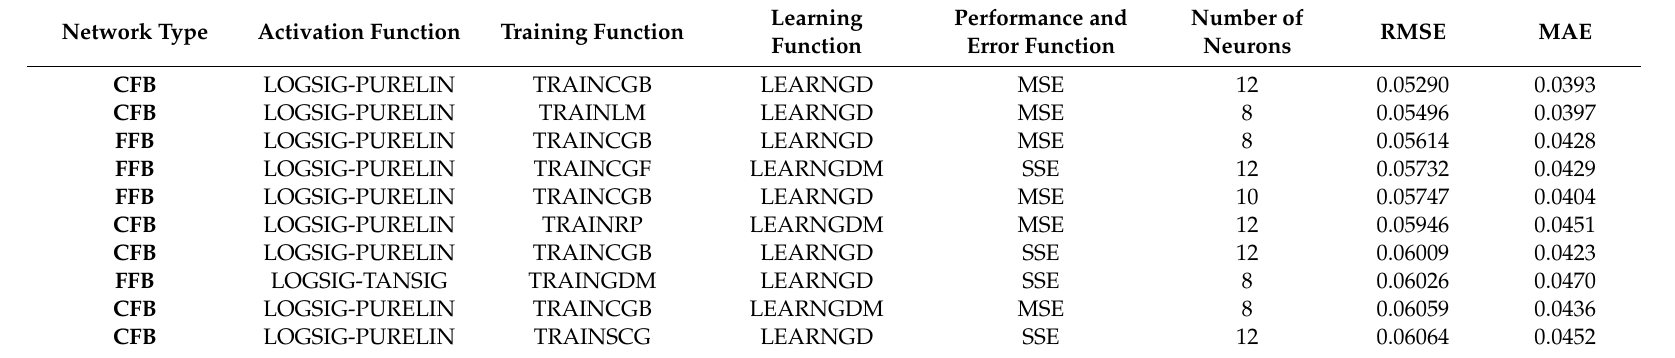
Table 2. The best results according to the RMSE and MAE